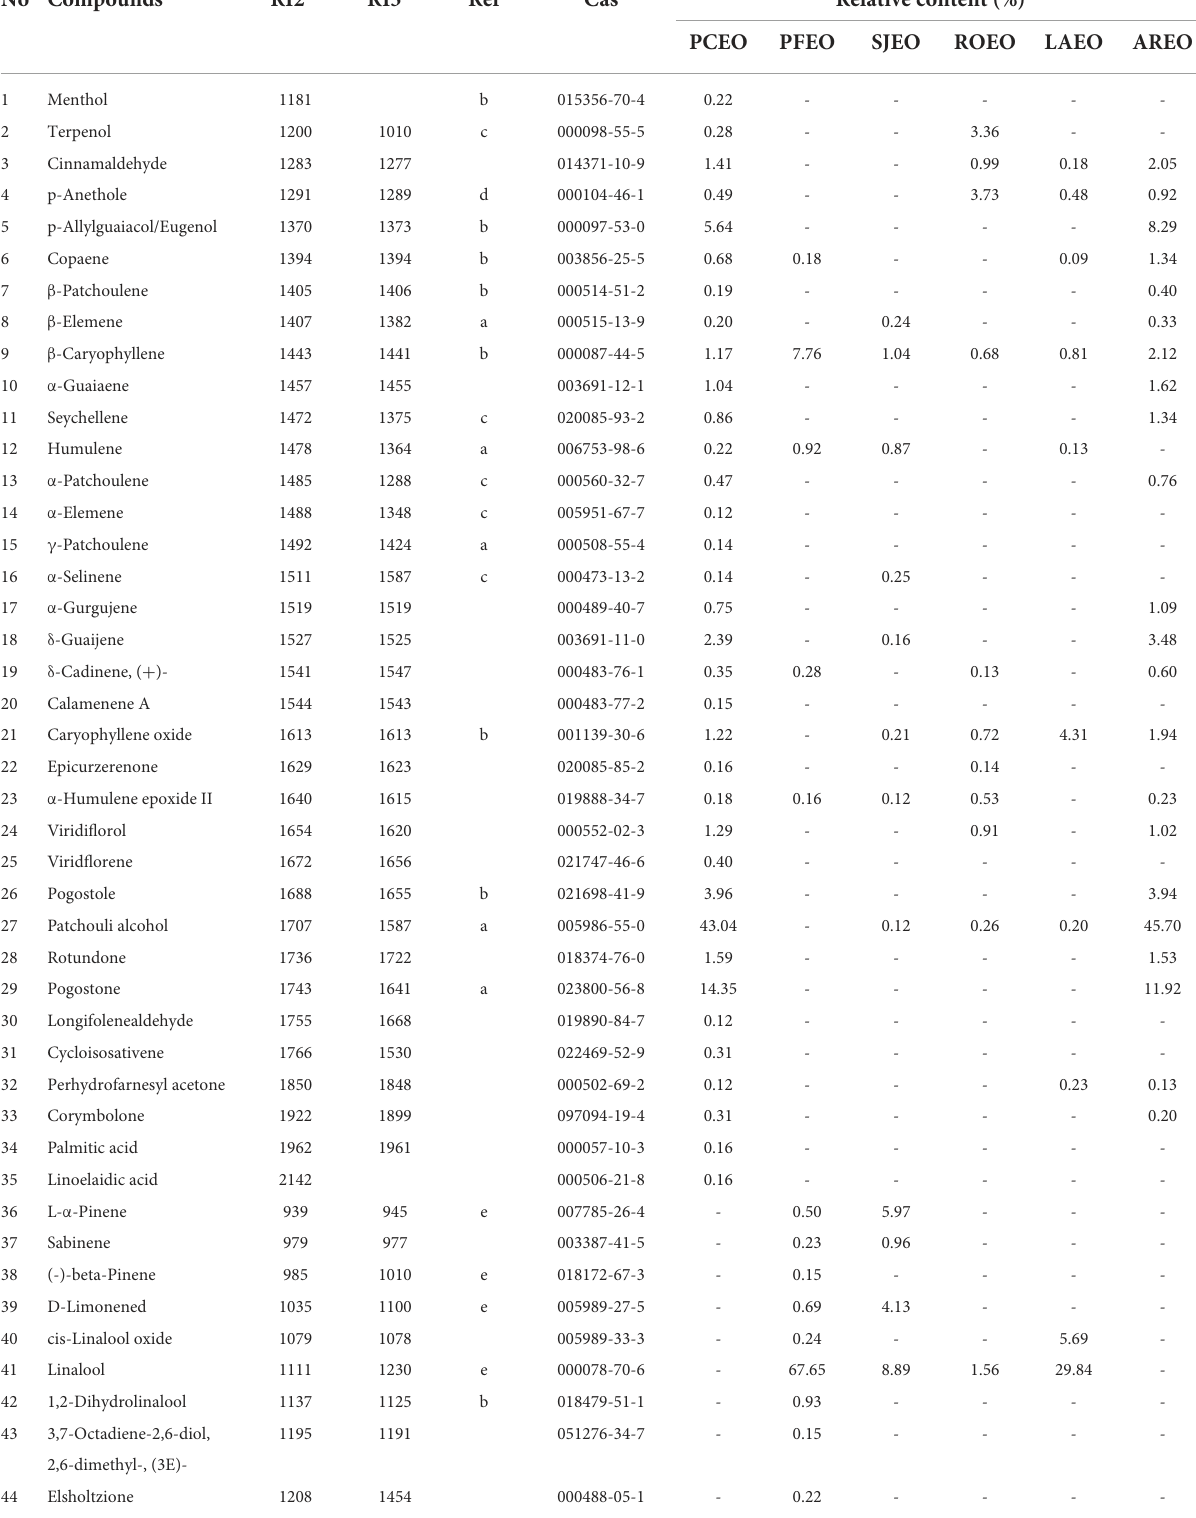
TABLE 2 Chemical compositions of six Lamiaceae